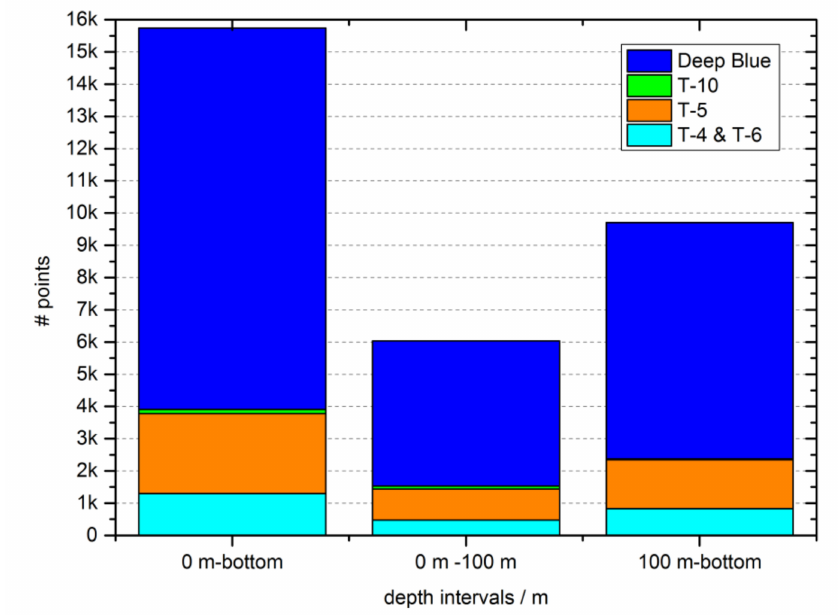
Figure 4. Number of matches XBT vs. Argo divided per XBT type and depth intervals (time window ± 7